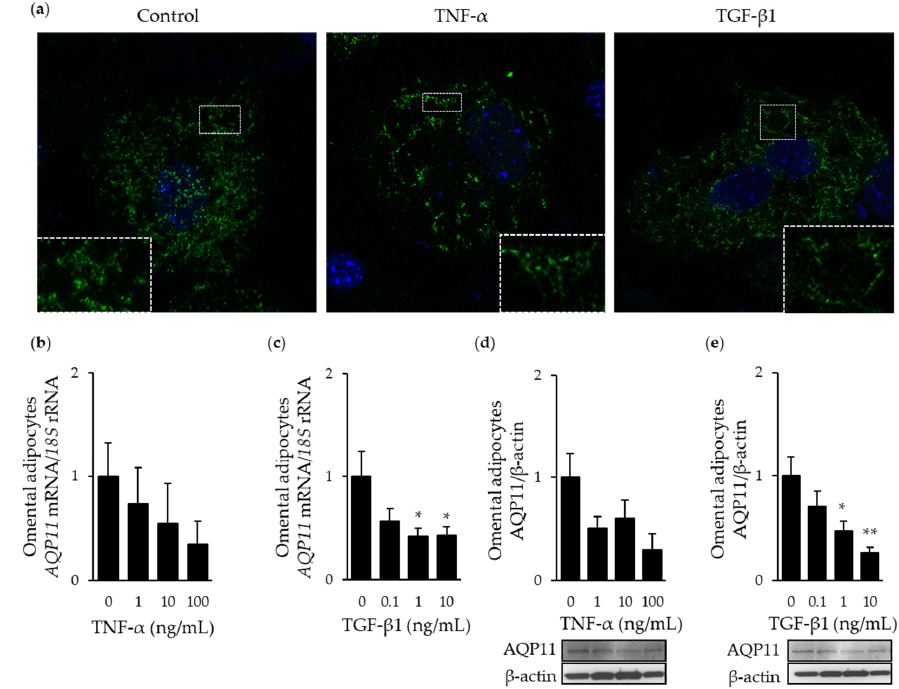
Figure 3. Proinflammatory factors TNF- α and TGF- β 1 induce changes in AQP11 expression and subcellular distribution. ( a ) Immunocytochemical detection of AQP11 in differentiated adipocytes (day 10) under basal conditions (left panel) and after the stimulation for 24 h with TNF- α (10 ng/mL) ( middle panel ) or TGF- β 1 (10 ng/mL) (right panel). Bar graphs show AQP11 mRNA ( b and c ) and protein ( d and e ) after 24 h treatment with different concentrations of TNF- α and TGF- β 1 in differentiated omental adipocytes. Representative blots are shown at the bottom of the histograms. * p <0.05, ** p < 0.01 vs unstimulated cells.